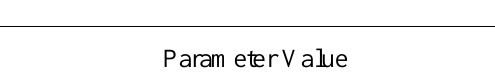
Figure A1. SCHC compression action